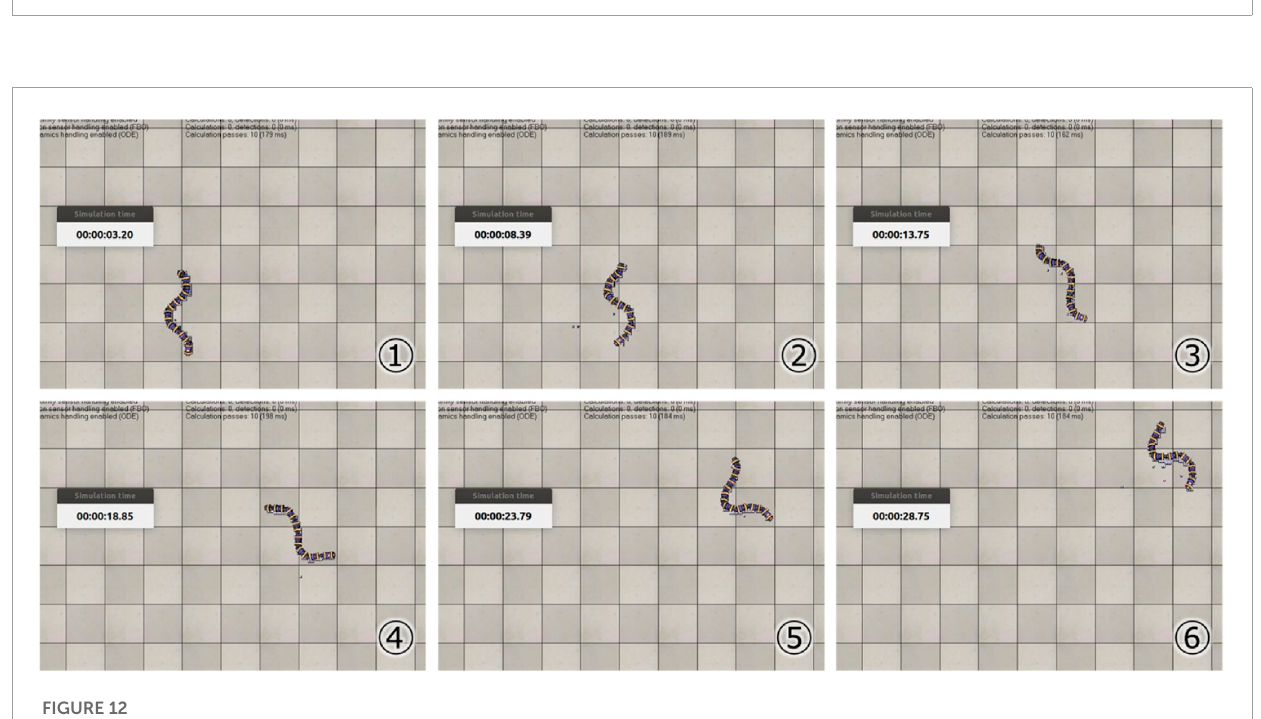
robot was unable to move appropriately because of the loss of tactile sensor